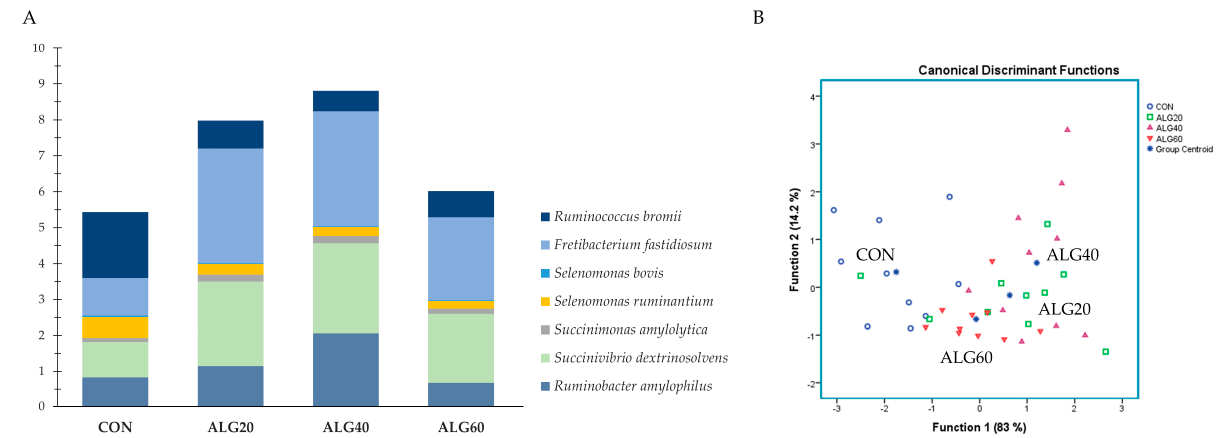
Figure 5. ( A ) Abundances of the most representative amylolytic species in the four dietary treatments (CON, ALG20, ALG40, and ALG60) within the two sampling times (20th and 40th days) illustrated in clustered stacked columns. ( B ) Discriminant plots separating the four dietary treatments (CON, blue ○ ; ALG20, green □ ; ALG40, purple △ ; and ALG60, red ▽ ) according to the pooled data of the two sampling times (20th and 40th experimental days) entered together as independents on the abundances of the seven principal species with amylolytic activity in the goats’ rumen. CON = control concentrate without microalgae ( Schizochytrium spp.); ALG20 = CON with 20 g/Kg Schizochytrium spp.; ALG40 = CON with 40 g/Kg Schizochytrium spp.; ALG60 = CON with 60 g/Kg Schizochytrium spp.